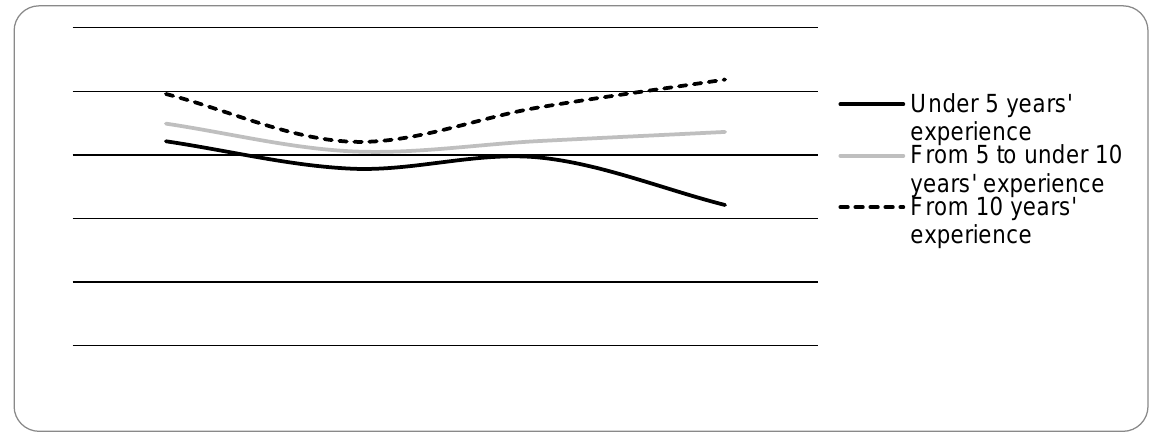
Fig 4: difference in experience years about leadership